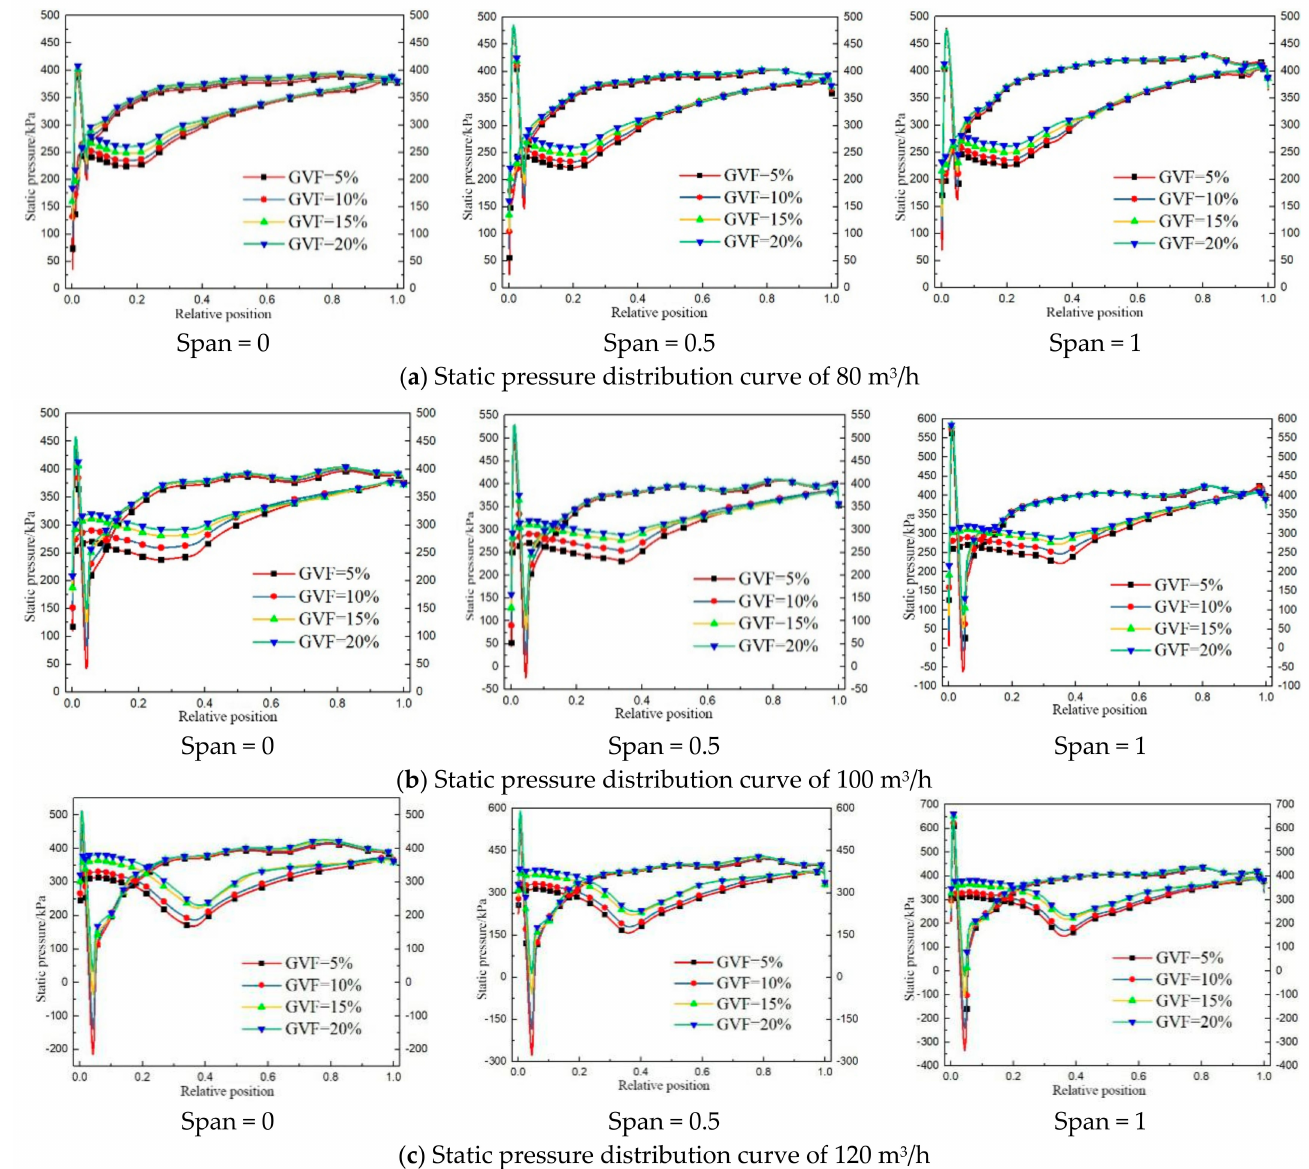
Figure 11. Static pressure distribution curve of multiphase pump under various